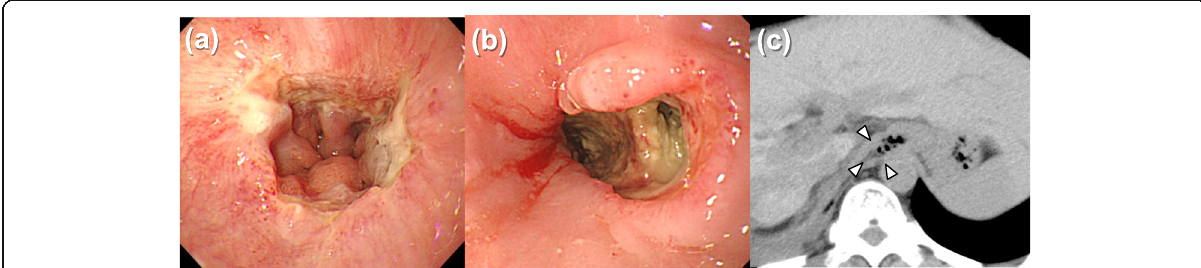
Fig. 3 Time series of the esophageal findings on upper endoscopy and CT . a After 6 months of the PBT, mucosal inflammation is noted in the lower esophagus. After 7 months of the PBT, b there is worsening of the esophageal ulcer into full-thickness necrosis, and c CT reveals a wall defect on the right side of the lower esophagus (white arrowheads). CT, computed tomography; PBT, proton beam